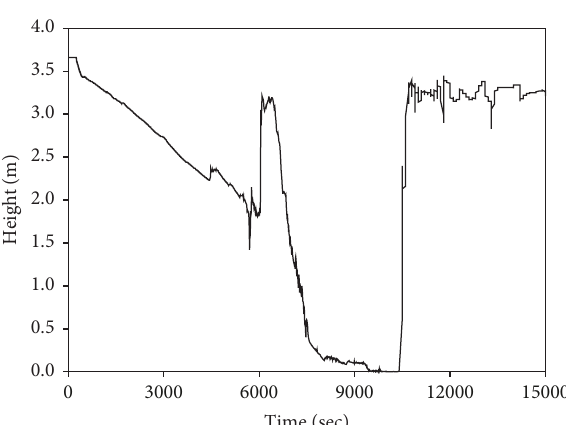
Figure 7: CINEMA results on collapsed water level in core of the TMI-2 severe accident.